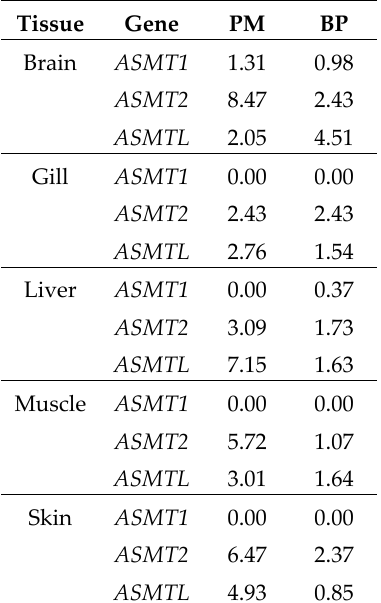
Table 3. RPKMs of ASMT transcripts in two mudskippers.